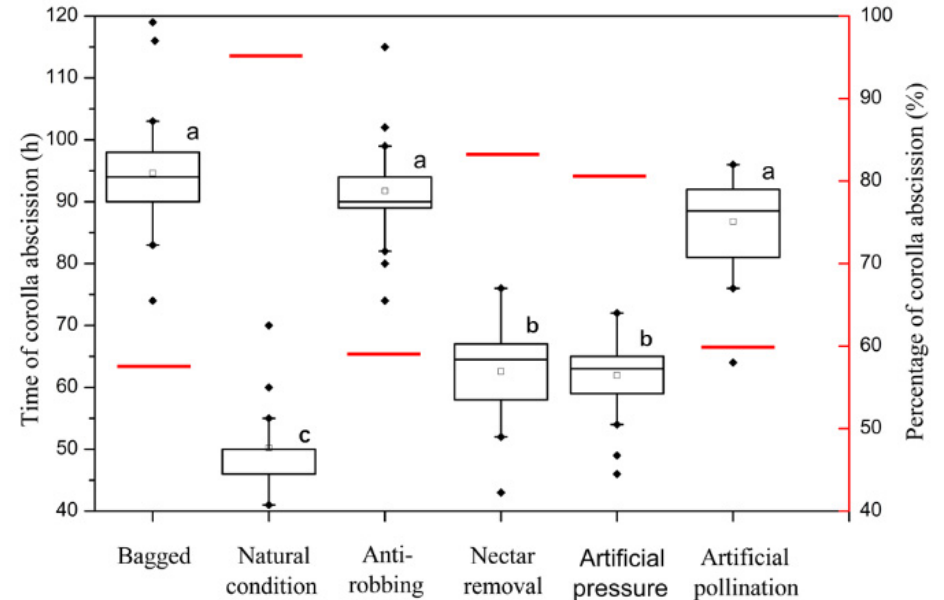
Figure 3. Time and proportion of corolla abscission under different treatments. Boxplots indicate the time of corolla abscission, showing medians, quartiles, interquartile ranges and outliers. The red line indicates the proportion of corolla abscission. Different letters on items indicate significant difference at the 0.05 level.